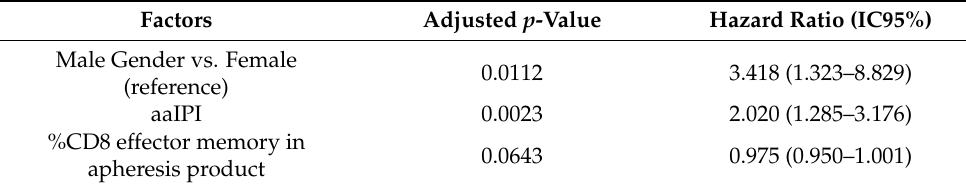
Table 3. Multivariate analysis of factors associated with PFS after CAR T-cells therapy. Factors Adjusted p -Value Hazard Ratio